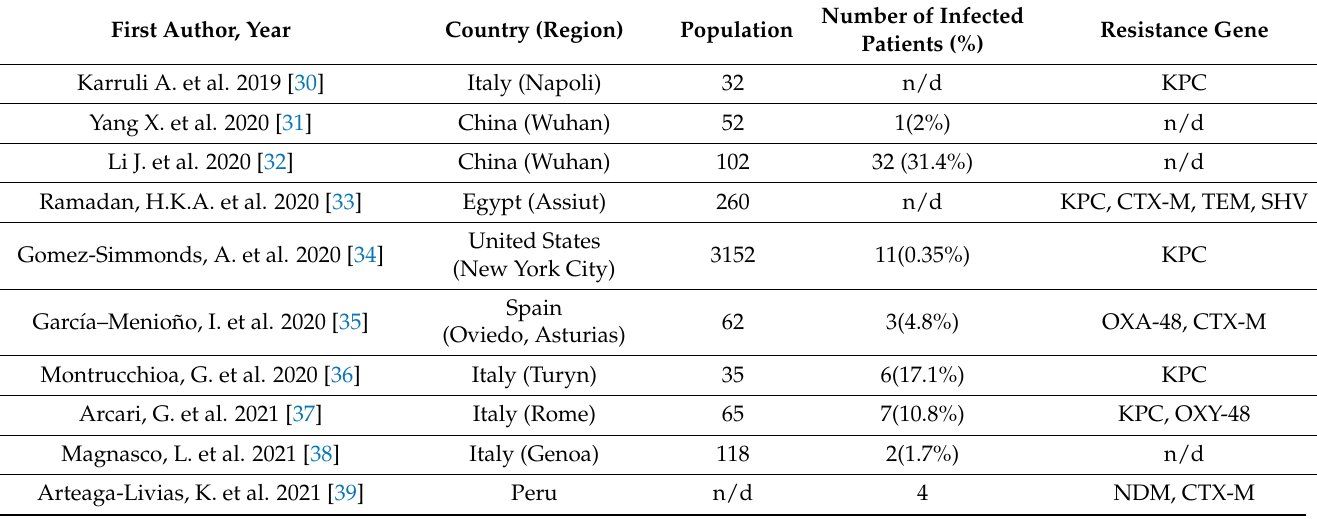
Table 5. Analysis of articles included in the scoping